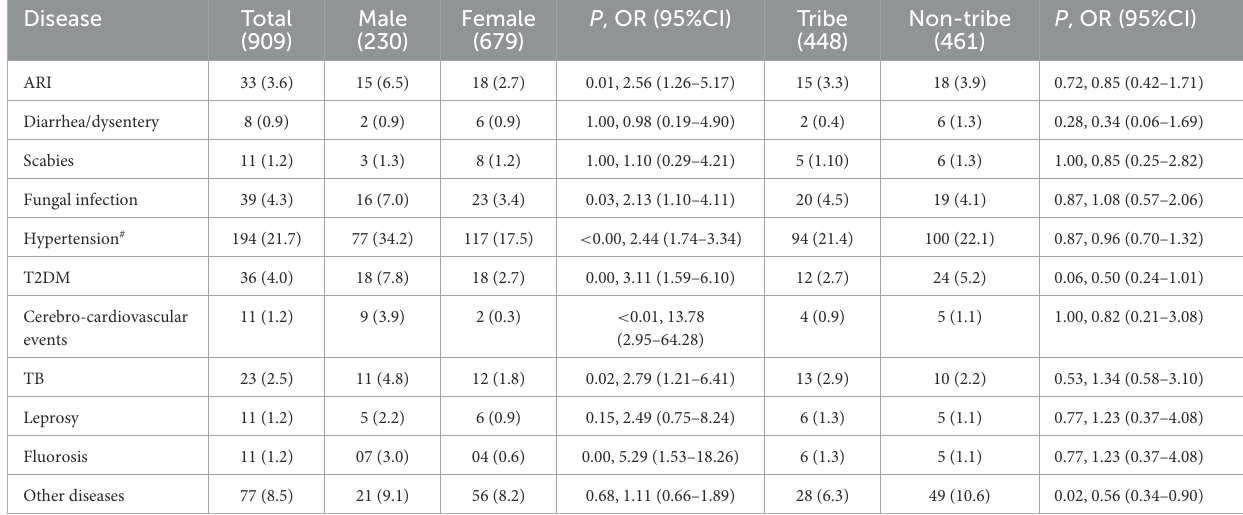
TABLE 2 Distribution of the presence of different morbidities among adults of Tamnar block ( n = 909).